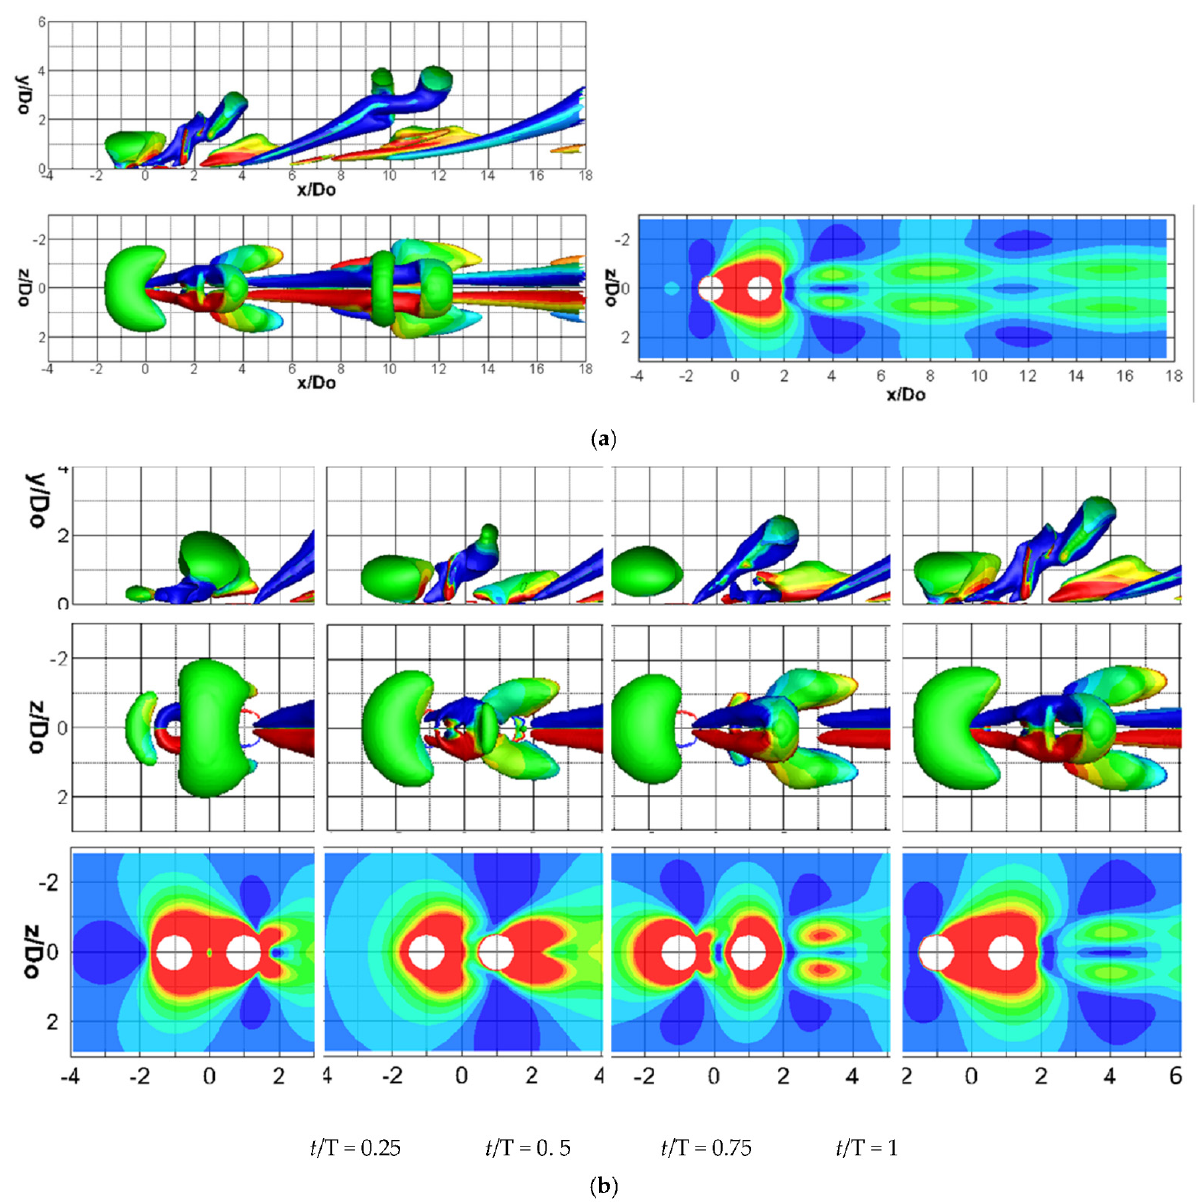
Figure 15. Vortex structures and excess wall shear stress for the twin SJs operating with ∆ φ = π . ( a ) Vortex structures ( left ) and excess wall shear stress ( right ) at t /T = 0. ( b ) Evolution of vortices ( upper two rows) and corresponding excess wall shear stress ( bottom row). The color map can be referred to Figure 11.